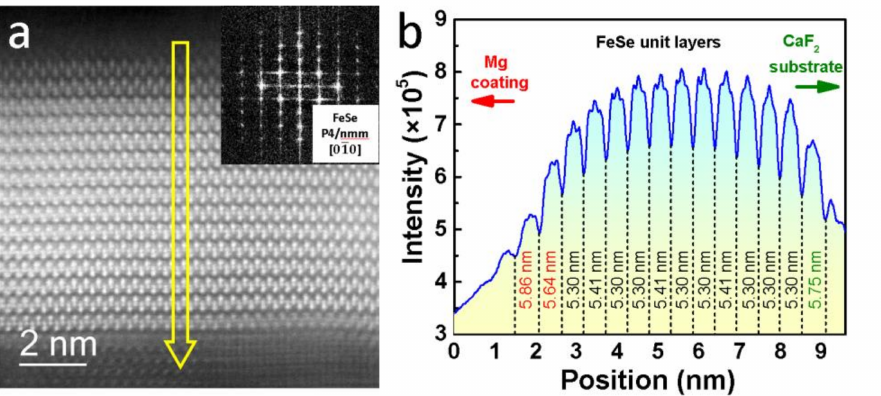
Figure 4. Scanning transmission electron microscopy (STEM) analyses for #UFM3 sample focusing on the cross-sectional region covering the entire FeSe layer. ( a ) Dark-field image. The inset provides a fast Fourier transform (FFT) pattern for FeSe core layers (zone axis on the contrast fluctuation of the arrow indicated in ( a ). The left/right side refers to the region of Mg-coating/CaF 2 substrate. The width values represent the c -axis lattice parameters of each FeSe unit